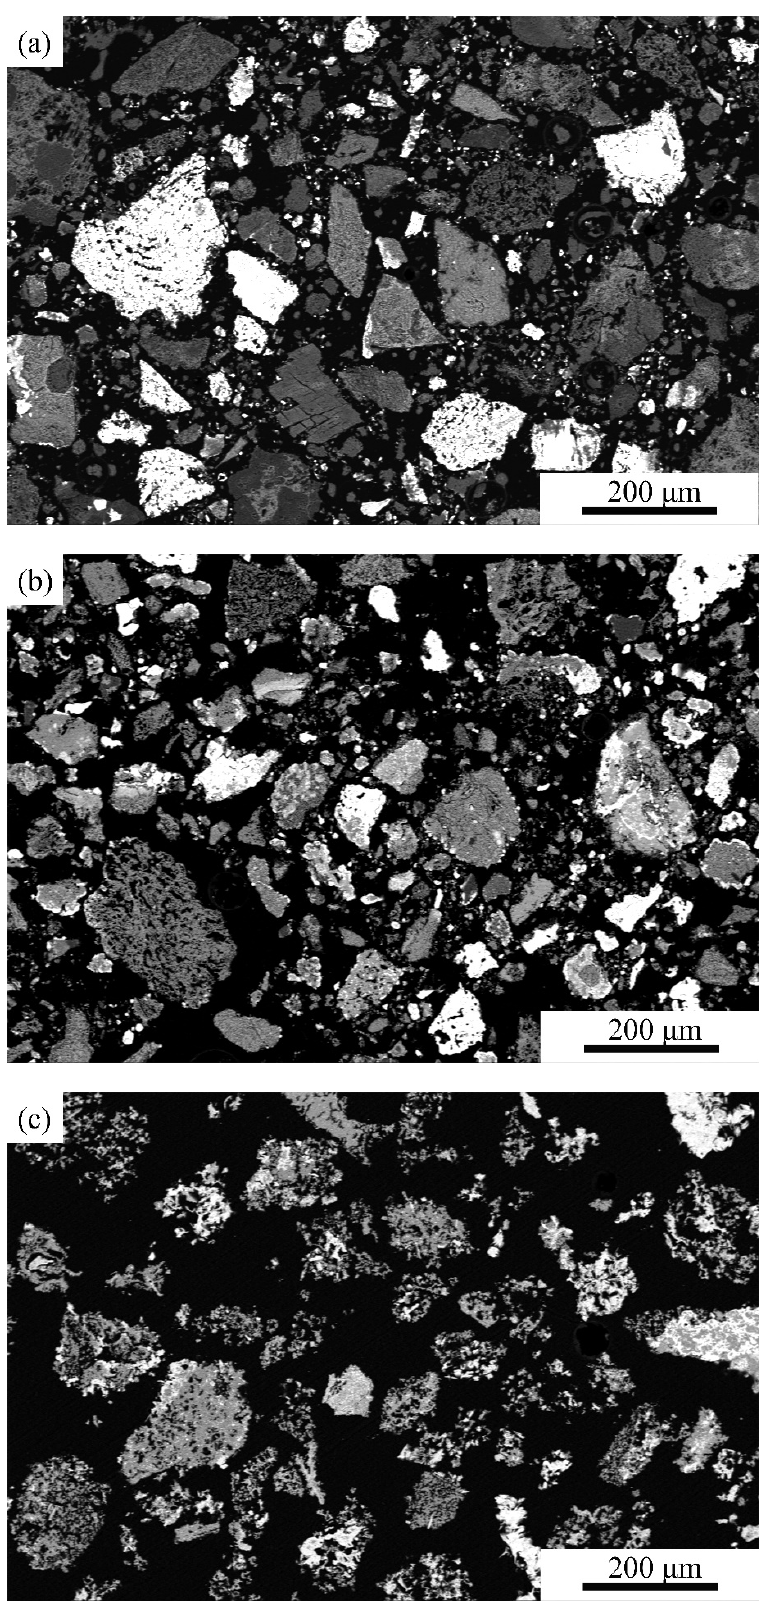
Figure 8. Backscattered electron images showing the morphology of the final products obtained under different simulated ( a ) 650. °C; ( b ) 750 °C; ( c ) 850 °C.